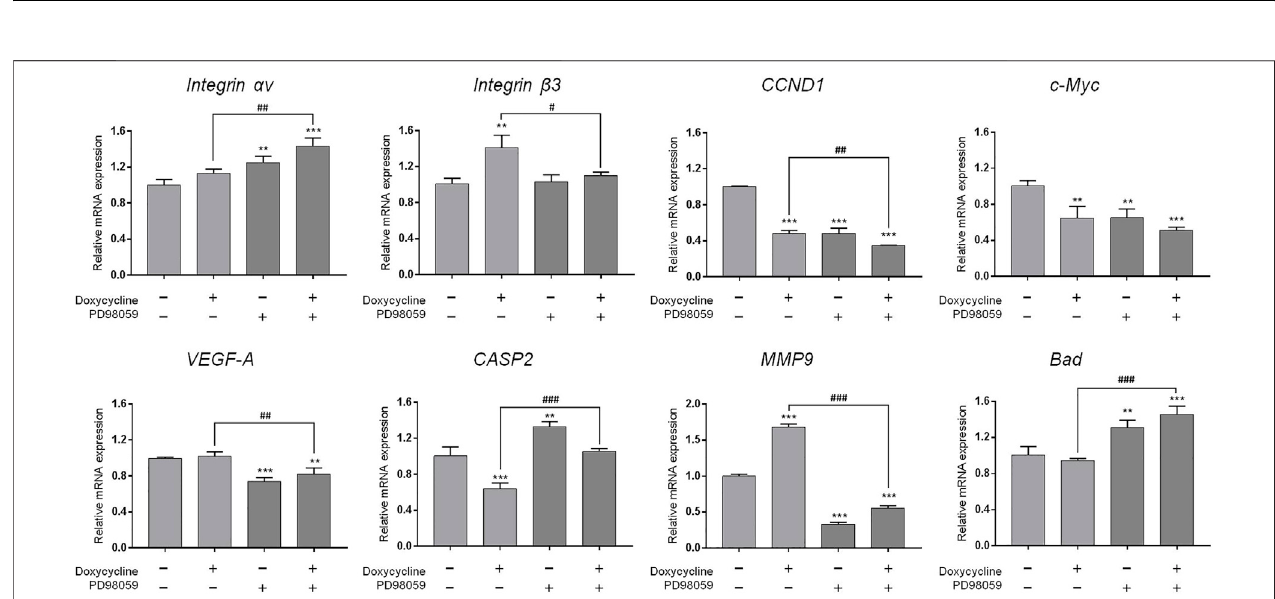
FIGURE5 | ERK1/2 activation plays an importantrolein doxycycline-induced gene expression inbreast cancerMDA-MB-231 cells. MDA-MB-231 cellswere pre- treated with PD98059 (25 µM) for 24 h, then treated with doxycycline (60 µM) for 24 h. Cells were harvested. RNA was extracted for qPCR. Numbers of independent studies ( n ) = 3. ANOVA was used to assess statistical signi fi cance. ** p < 0.01, *** p < 0.001, compared to the untreated control. # p < 0.05, ## p < 0.01, ### p < 0.001, compared to doxycycline alone.